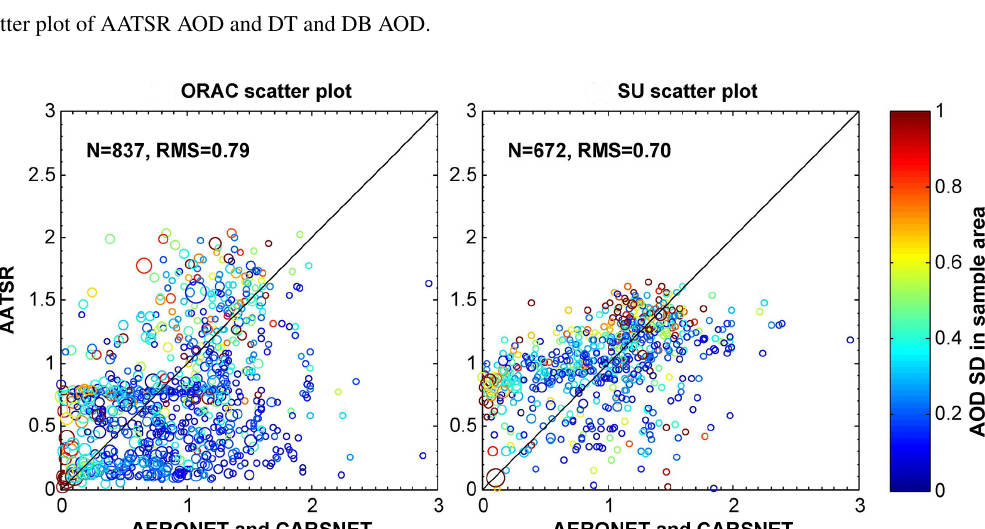
Figure 16. Comparisons of Ångström exponent of ORAC and SU products. The area and colours of bubbles represent AOD uncertainty and AOD values,